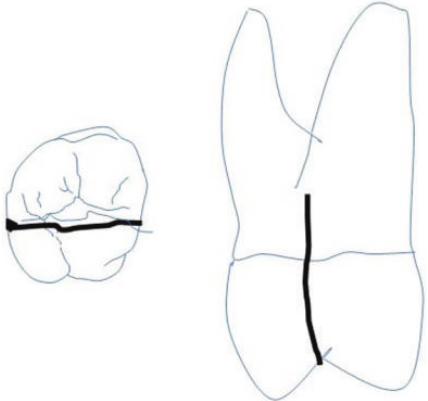
Figure 3: Preoperative photograph showing fractured cusps in 37 and 46.